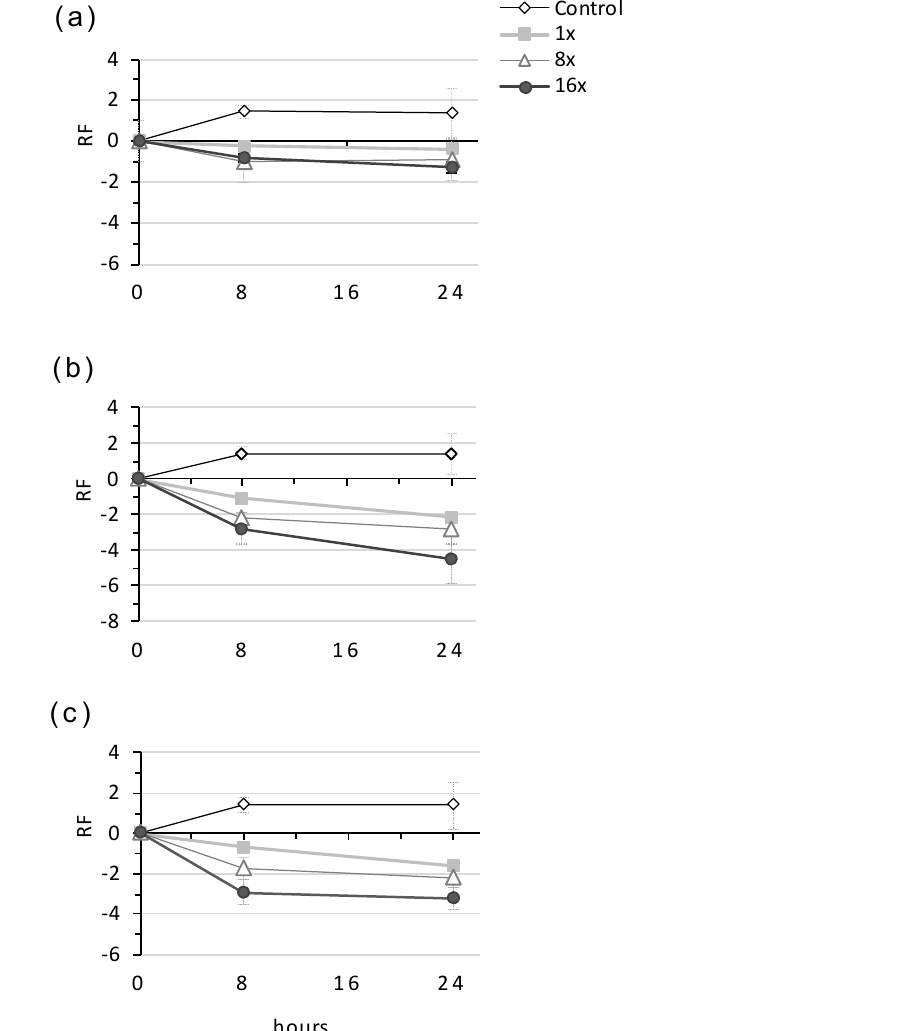
Figure 5. Antagonistic effect of NPBD on the action of tetracycline against Enterococcus faecalis . ( a ) NPBD alone; ( b ) Tetracycline ( c ) NPBD & tetracycline in equal proportions. MICi for tetracycline and NPBD was 16 mg/L.